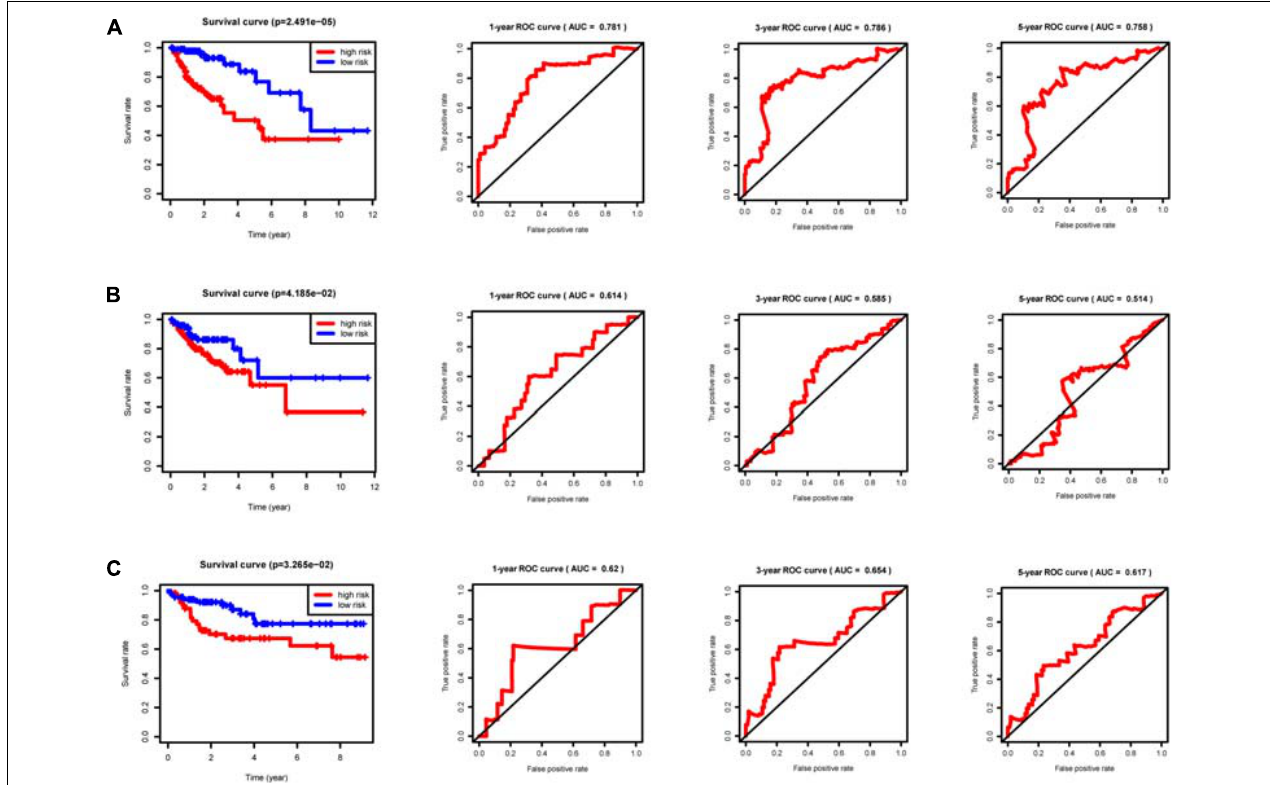
FIGURE 5 | Clinical prognostic model evaluation. The riskScore of the clinical prognostic model can predict survival rate according to Kaplan–Meier (KM) survival analyses for the high and low risk groups. The ROC curve is used to evaluate the prediction efficiency of the prognostic model and validate the prognostic value